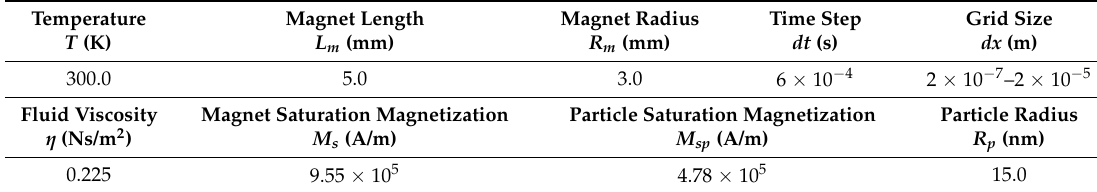
Table 1. Simulation